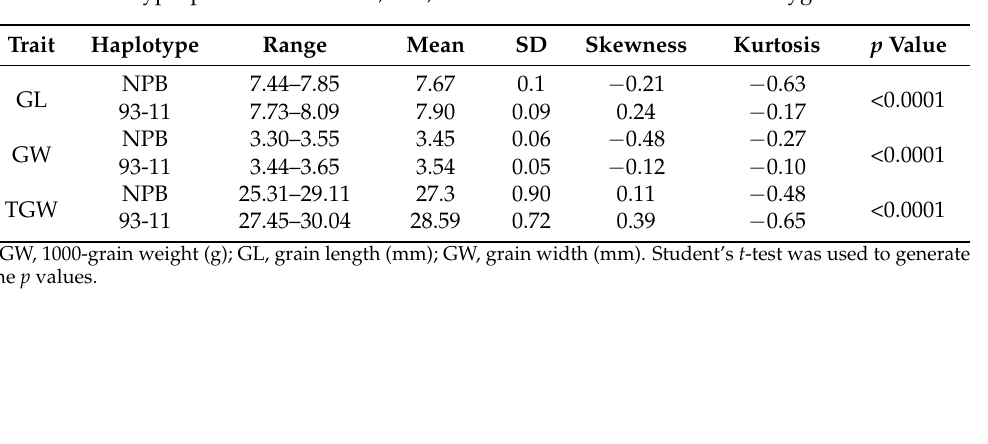
Figure 5. Frequency distribution of GL, GW, and TGW of NPB and 9311 homozygotes in the BC 9 F 3 population. Table 2. Phenotypic performance of GL, GW, and TGW in NPB and 93-11